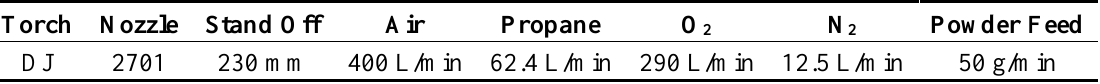
Table 1. Coating parameters for HVOF spray of the FeNiCrAl